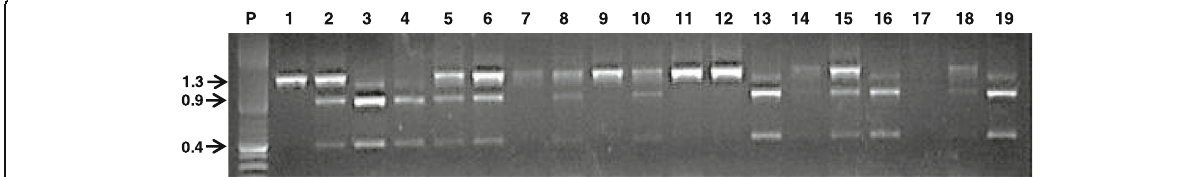
Fig. 1 Representative gel of the polymorphism pattern resulting from the restriction with Xba I of amplified samples for the estrogen receptor alpha. Samples with one band only indicate a wild profile (~ 1300 pb, eg., lane 12), whereas samples with three bands (~ 1300, ~ 900, and ~400pb, eg., lanes 2 and 5) and with two bands (~ 900 and ~400pb, eg., lanes 3 and 4) indicate the heterozygous and homozygous profiles for mutation, respectively. The arrows point to the migration of each of the expected fragments. P, molecular weight standard (100 pb step